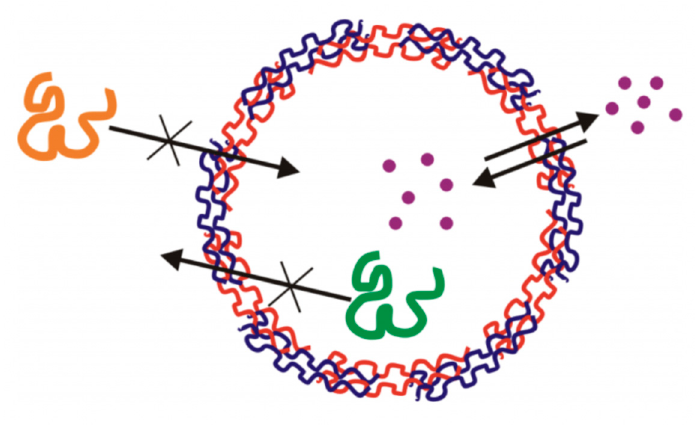
Figure 1. Schematic representation of the permeability of the capsule shell to small, low molecular weight drugs and water molecules (purple), as well as larger, impermeable molecules (orange/green). This schematic is taken with permission from Reference [59], copyright © 2011, Elsevier.